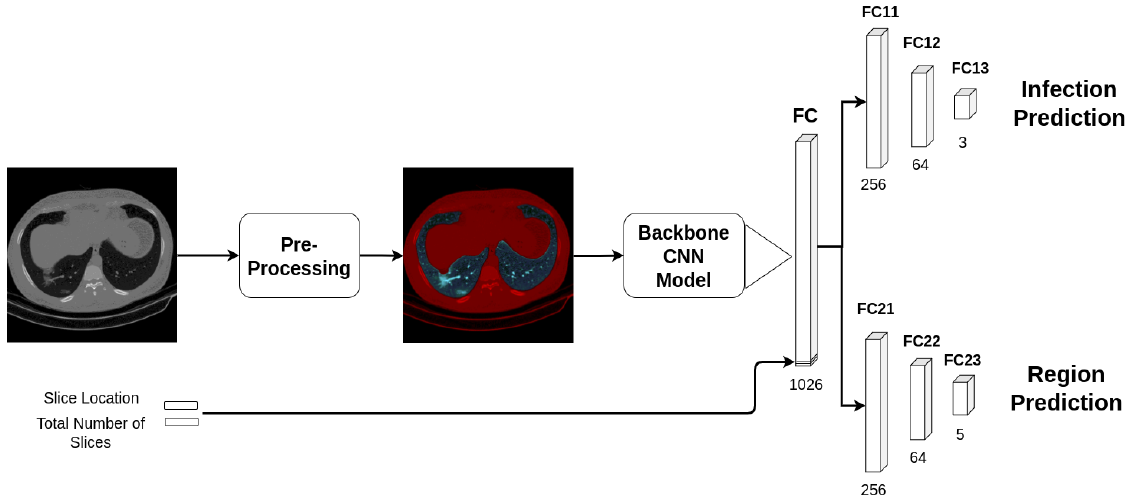
Figure 4. Multi-tasks slice-level training using CNN